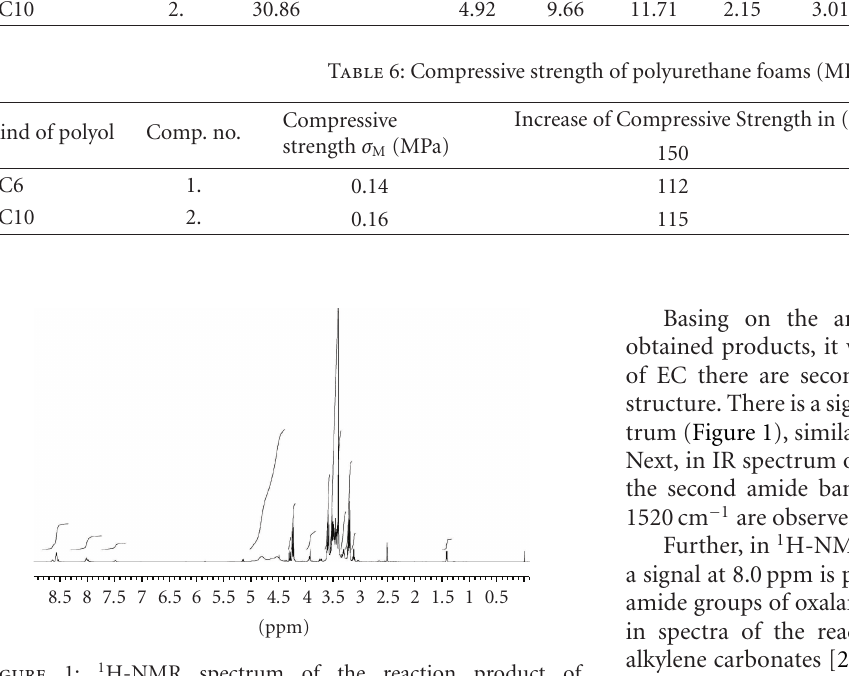
Figure 1: 1 H-NMR spectrum of the reaction product of BHEOA:EC 1: 2 in the presence of 0.06 mole K 2 CO 3 /mole OA at